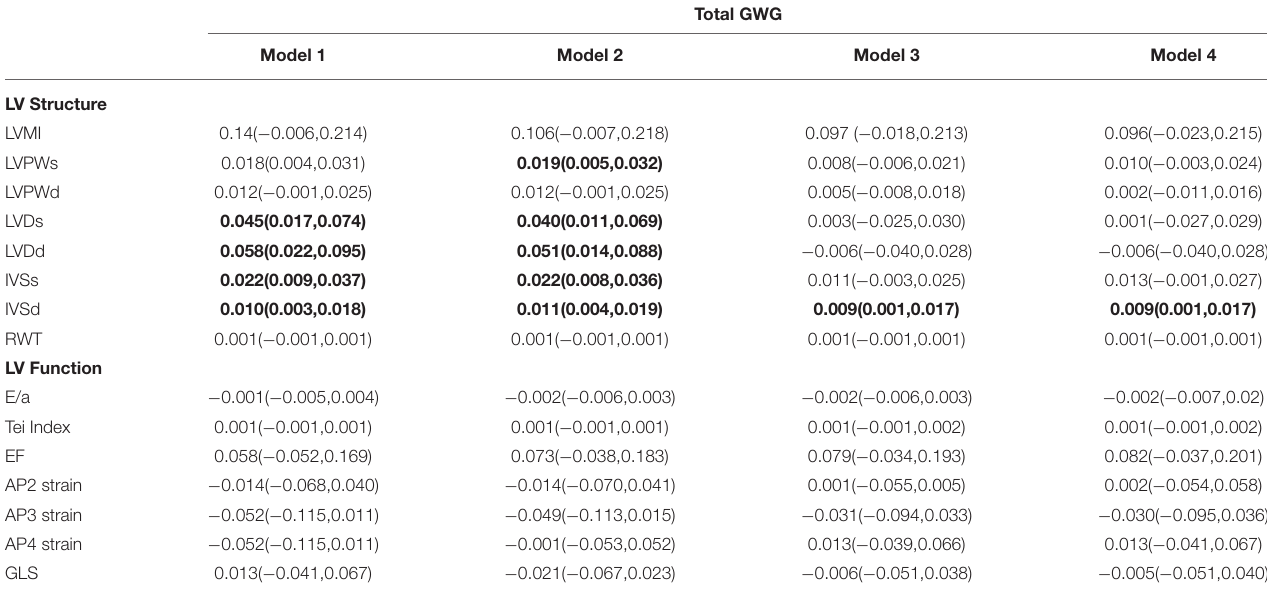
TABLE 1 | Association between maternal total GWG and offspring LV geometry and